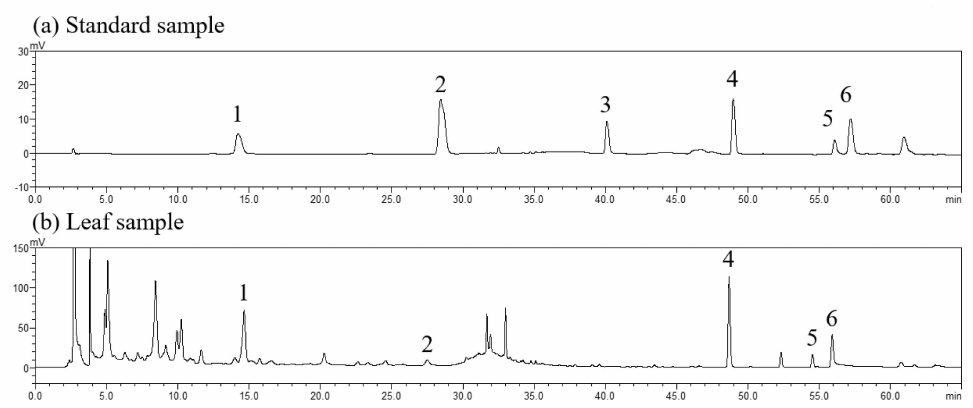
Figure 5. HPLC chromatograms in the determination of standard sample ( a ) and leaf sample ( b ). Among them, 1, 2, 3, 4, 5, and 6 in the figure represent polydatin, resveratrol, aloe-emodin, emodin, chrysophanol, and physcion, respectively.